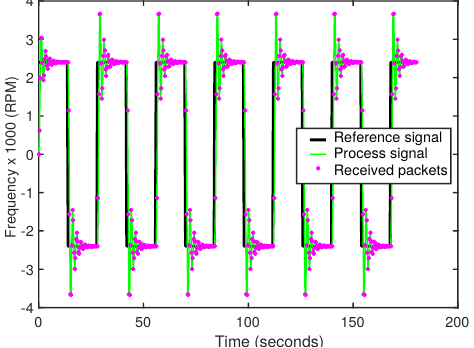
Figure 9. Operation of the process without loss of